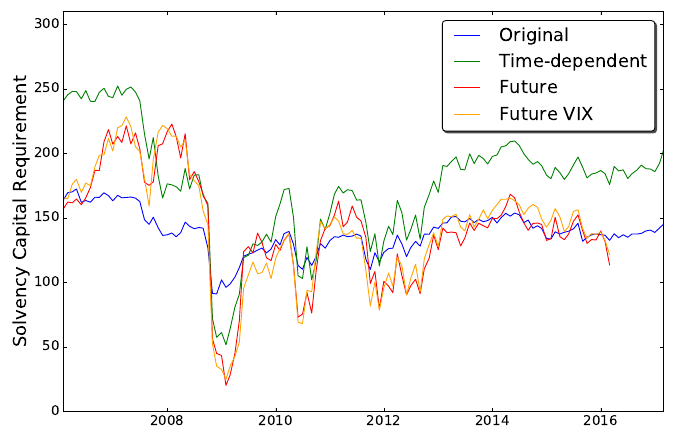
Figure 5. SCR over time under the different risk-neutral measures. Table 6. Difference in SCR between original and time-dependent risk-neutral